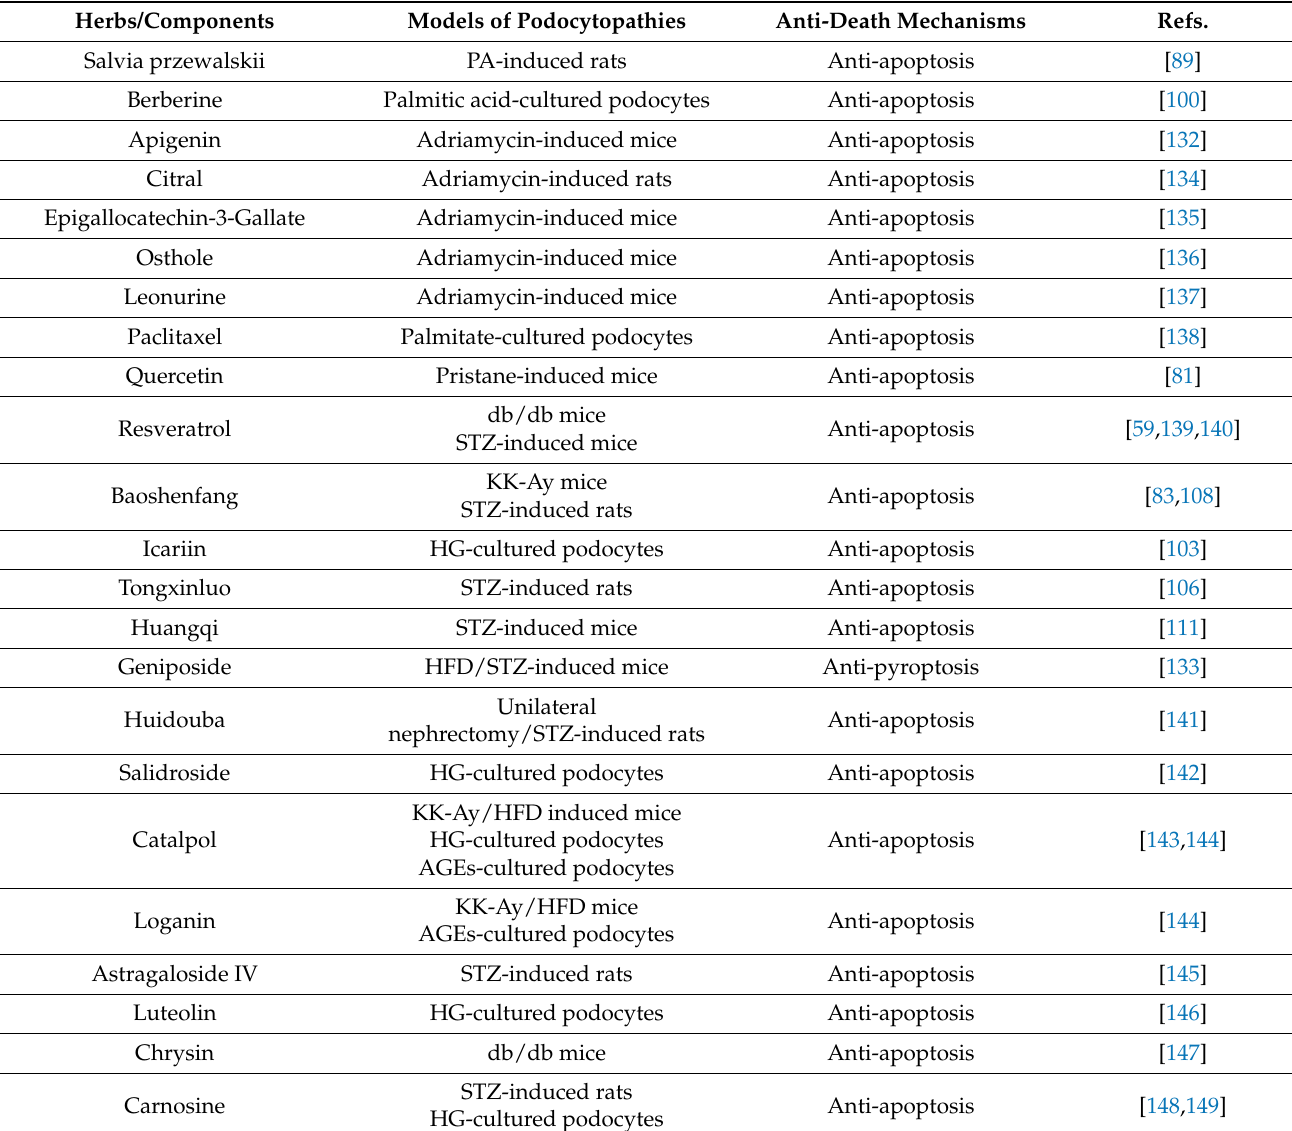
Table 1. A summary of antioxidative herbs and herb-derived components that can protect the podocyte from